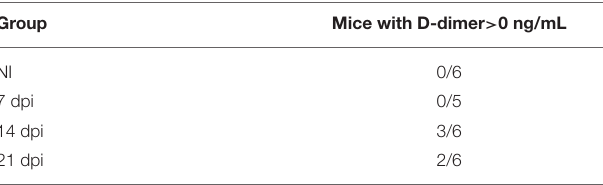
TABLE 2 | Serum contents of D-dimer during acute phase of oral T. cruzi infection.